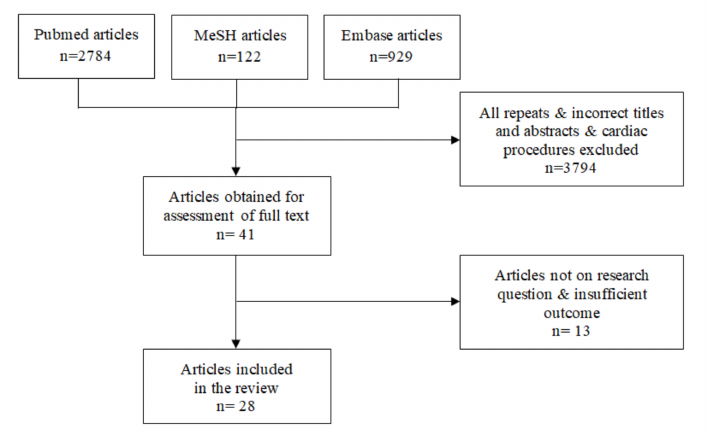
Figure 1. Flow chart of the screened and included